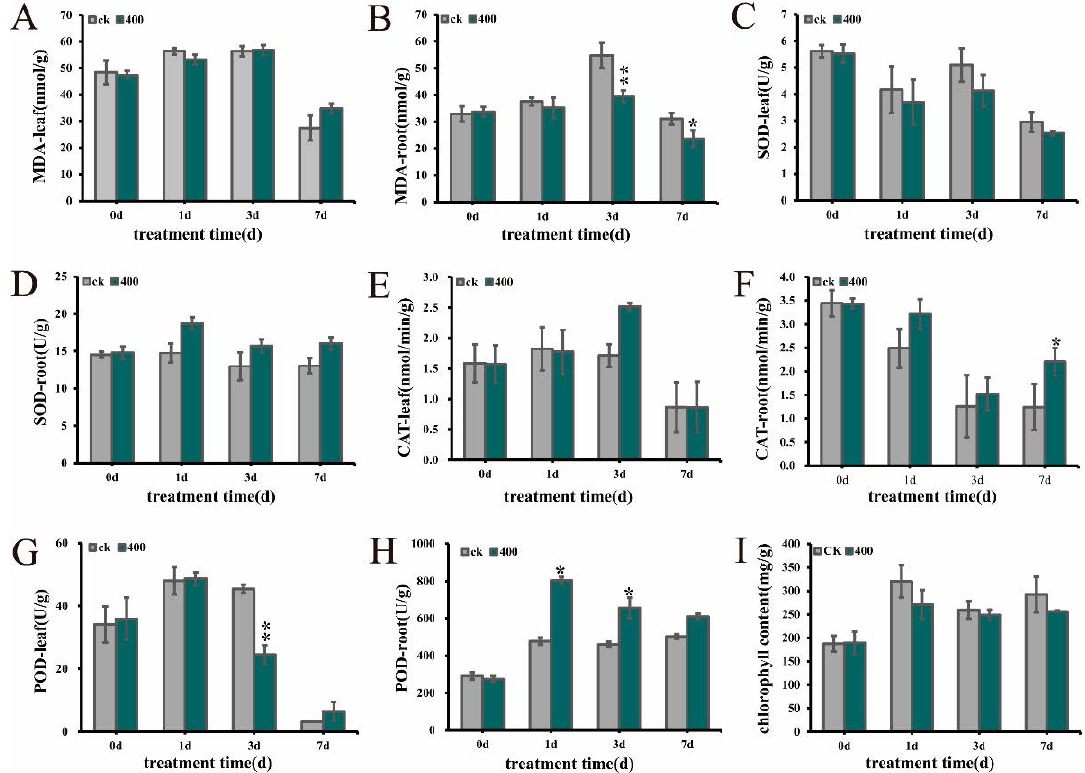
Figure 4. Effects of aluminum stress on ROS and chlorophyll. ( A - H ) Changes of ROS in leaves and root tips. ( I ) Chlorophyll content change. The error line represents the average ± SD of the three organisms. The * above the column chart shows that the content of elements between the two samples was significant (Students’ t -test, * p < 0.05, ** p < 0.01).